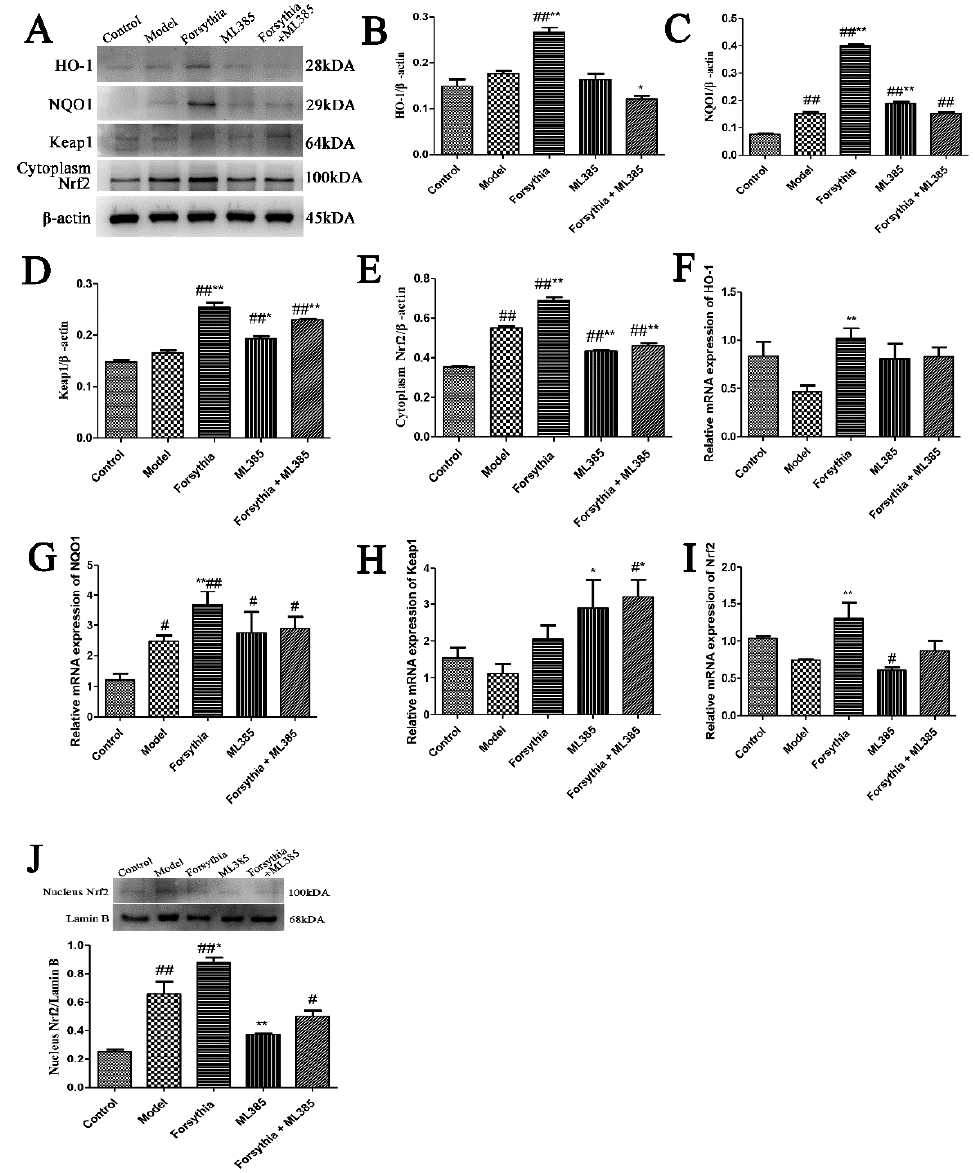
Figure 9. The inhibitor ML385 reverses the antioxidant effect of Forsythia suspensa extract. ( A – E ) Western blot analysis of HO-1, NQO1, Keap1 and cytoplasm for Nrf2. ( F – I ) qRT–PCR detection of HO-1 , NQO1 , Keap1 and Nrf2 gene expression levels. ( J ) Western blot detects the level of nuclear Nrf2. The results are shown as the mean ± SEM. # p < 0.05, and ## p < 0.01 compared with the control group; * p < 0.05, and ** p < 0.01 compared with the model group; #** means # and **; ##** means ## and **.